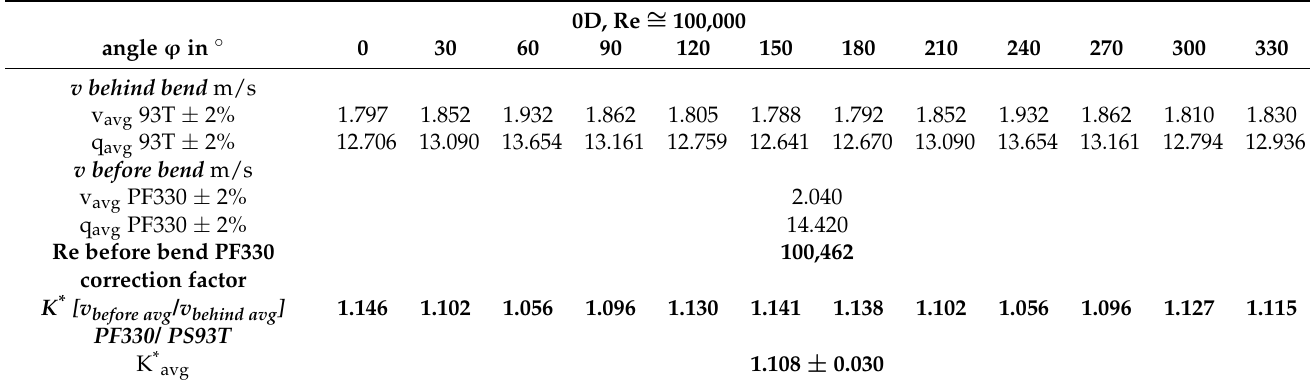
Table 4. Summary of the results of ultrasonic measurements for the 0D plane from the disturbing element as a function of the mounting angle of the ultrasonic flow meter sensors, Re ∼ =